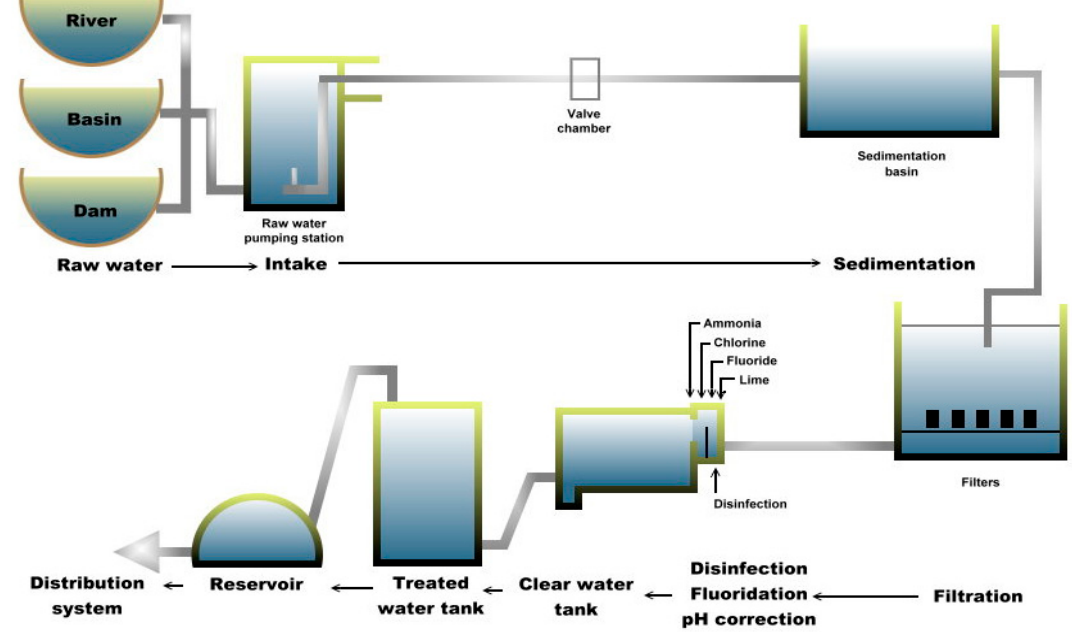
Figure 2. Schematic diagram of Plant B.